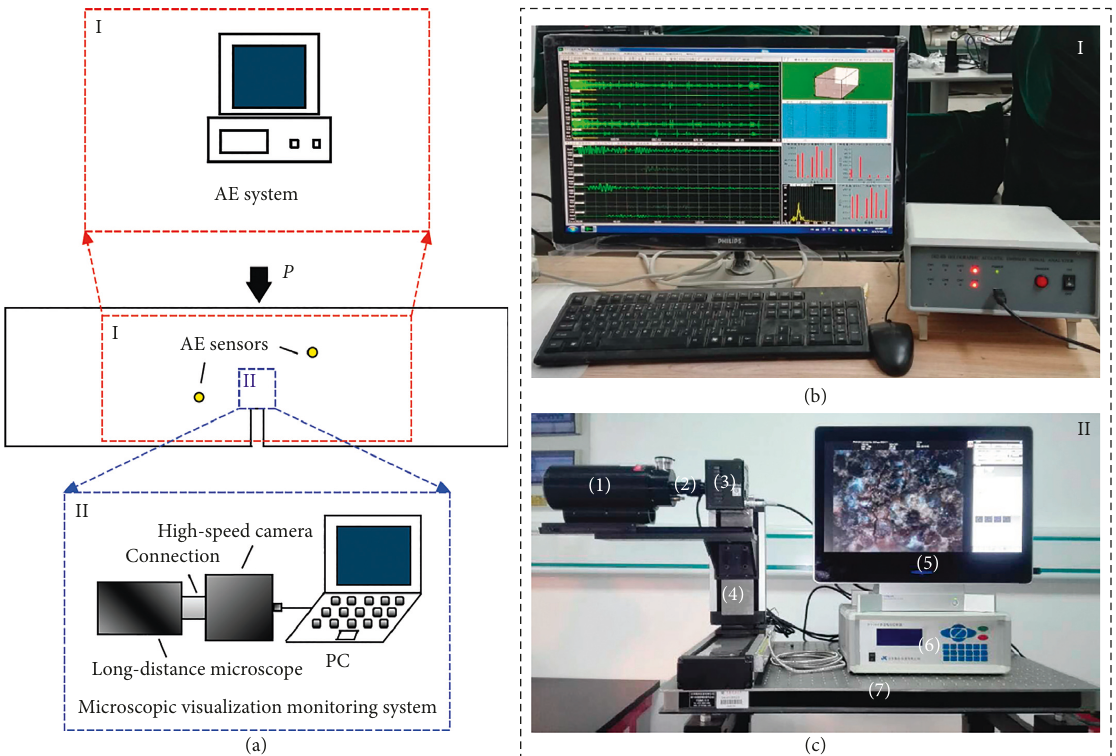
Figure 2: Real-time in situ cracking microscopic visualization monitoring system: (a) schematic of the test system, (b) AE monitoring system, and (c) microscopic visualization monitoring system. Note: (1) long working distance microscope, (2) C-mount interface, (3) high- speed video camera, (4) precision electric mobile platform, (5) image acquisition and control system, (6) stepping motor controller, and (7) shock absorbing ground support.